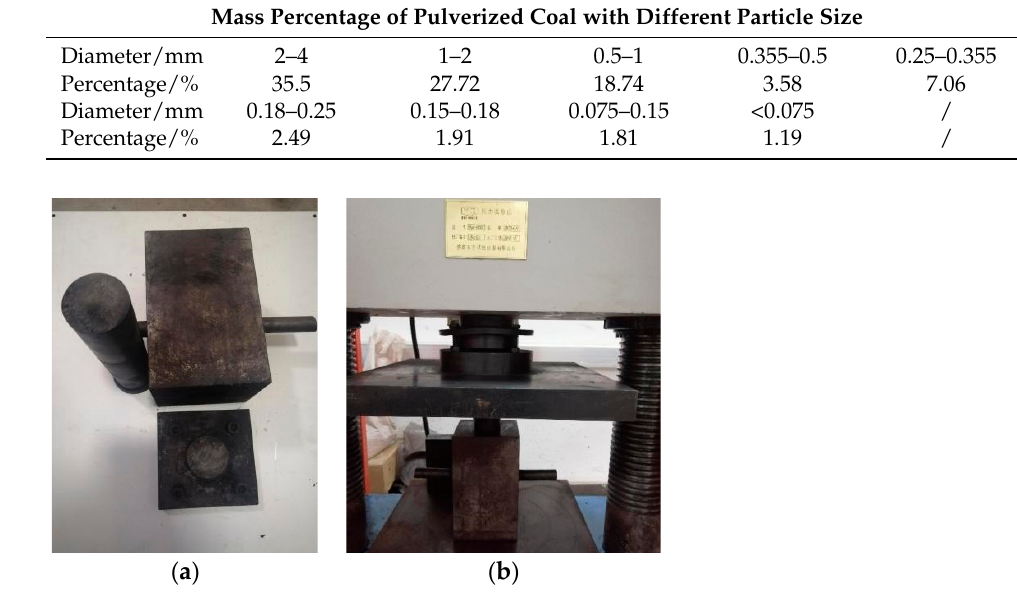
Figure 1. Steel mold and electric-hydraulic serving compression machine. ( a ) Steel mold; ( b ) electric- hydraulic serving compression machine.